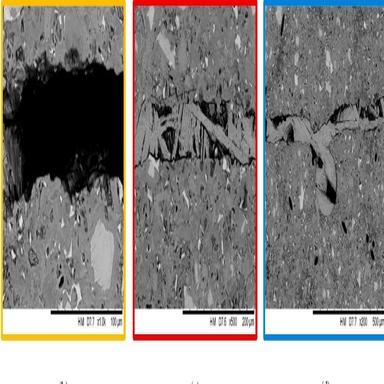
(a) Extended field image of a polished section showing healing products along the crack in samples with 2% CA, and 178 days of hydration age. (b) (c) (d) SEM micrographs (BSE images) with higher magnifications, showing different degrees of filling of the internal crack region.